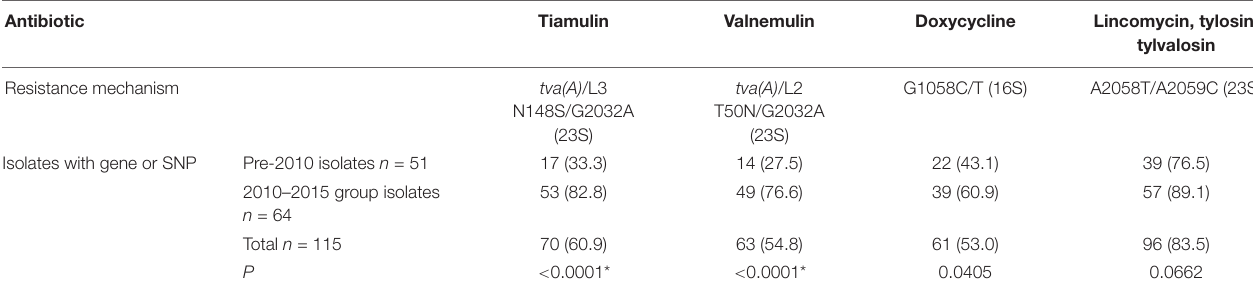
Antibiotic Tiamulin Valnemulin